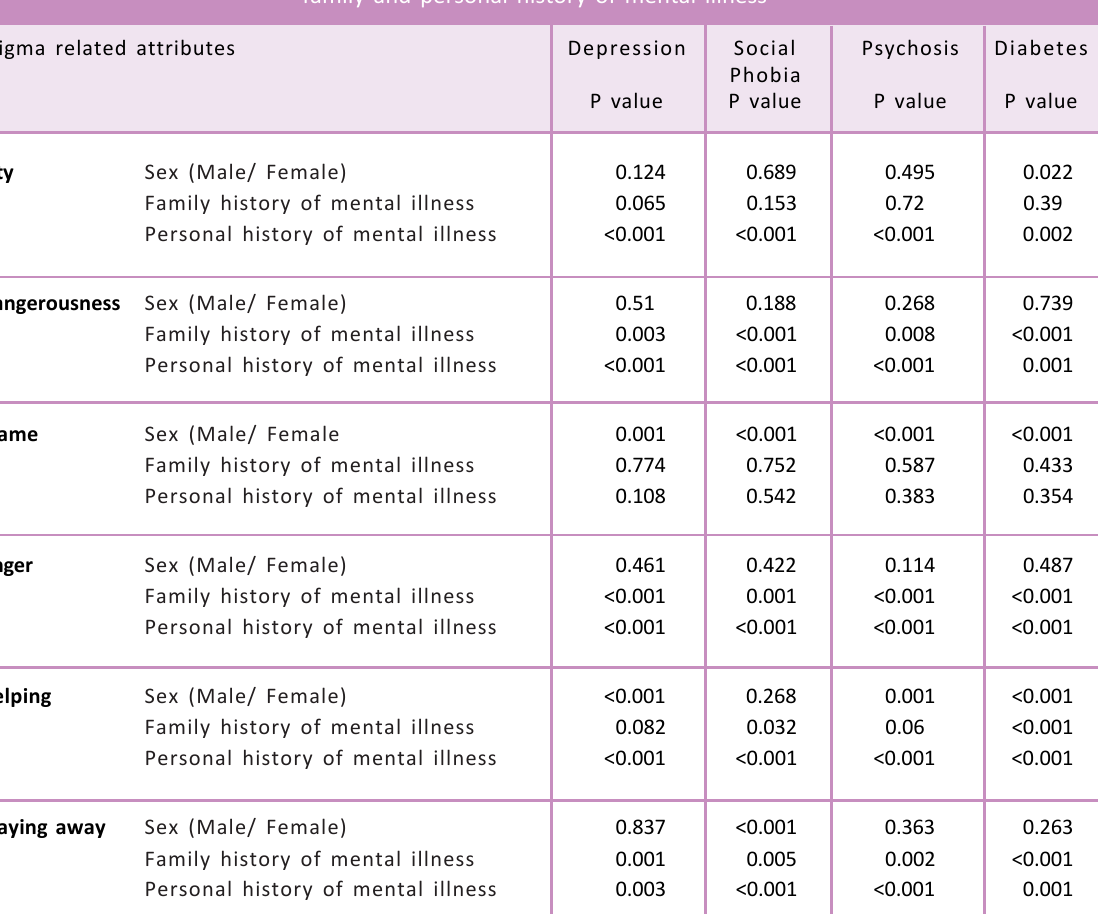
Table 3: Comparison of median values of the stigma questionnaire, with respect to sex, family and personal history of mental